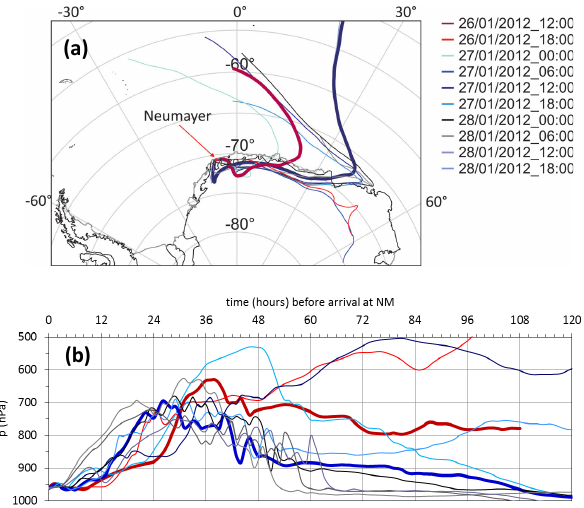
Figure 5. Five-day back trajectories based on 3-D wind fields for the period 26 January 2012–28 January 2012: horizontal advec- tion pattern (a) and vertical profiles (b) . Trajectories which arrived around the main NPF events (noon on 26 and 27 January 2012) are plotted as bold